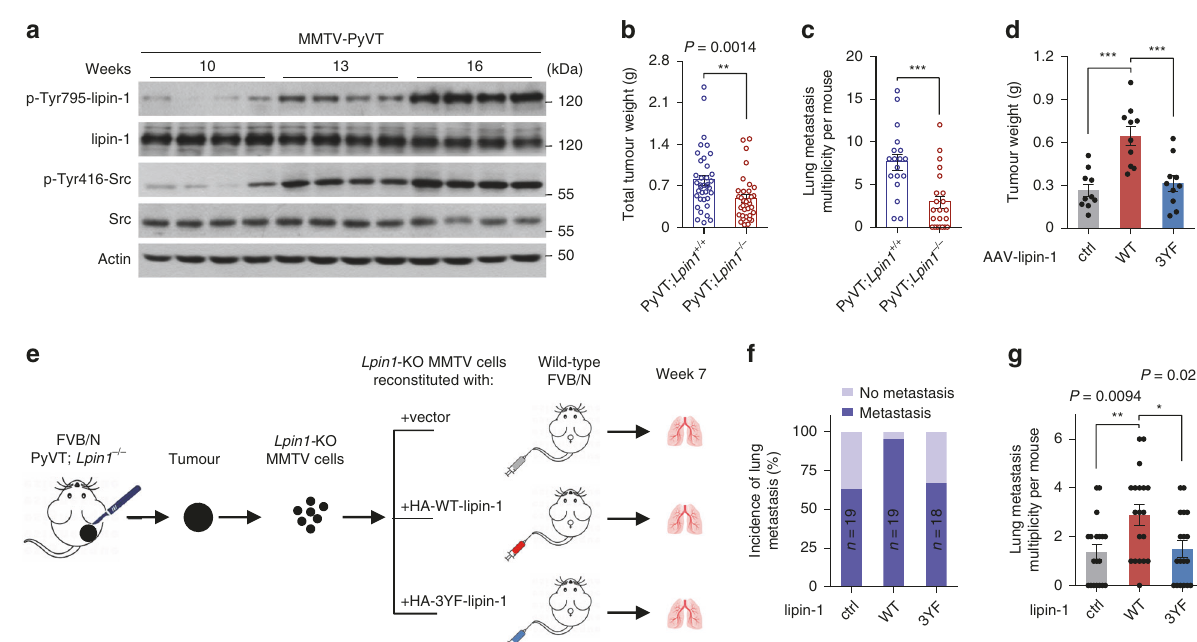
Fig. 4 Src-mediated lipin-1 phosphorylation is crucial for breast cancer progression in mice. a Immunoblots of breast tumour extract from MMTV-PyVT mice at 10, 13 and 16 weeks. Each lane represents proteins from one mouse. b Tumour weights of PyVT; Lpin1 + / + ( n = 37) and PyVT; Lpin1 − / − ( n = 34) mice. Experimental mice were killed at 14 weeks of age, and mammary tumours were then removed and weighed. n = 34 – 37 mice per group. c Multiplicity of lung metastasis. Metastasis multiplicity was determined by H&E staining of 14-week-old PyVT; Lpin1 + / + ( n = 18) and PyVT; Lpin1 − / − ( n = 22) mice. d Tumour weights of PyVT; Lpin1 − / − mice infected with adeno-associated viruses (AAV) carrying vector (ctrl), WT-lipin-1 or 3YF-lipin-1. The 6-week-old female Lpin1 − / − mice were anaesthetised and injected with 1 × 10 11 genome copies of AAV per fat pad, at 6 weeks post-injection, tumour weights of these mice were measured. n = 10 mice per group. e Schematic diagram of intravenous injection to generate experimental lung metastasis. Lpin1- KO MMTV cell line was isolated from a spontaneous mammary tumour in PyVT; Lpin1 − / − mice. 1 × 10 5 Lpin1- KO MMTV cells expressing GFP (ctrl), WT-lipin-1 or 3YF- lipin-1 were injected intravenously into 6-week-old FVB/N female mice ( n = 19 mice for ctrl or WT-lipin-1 group, n = 18 mice for 3YF-lipin-1 group). f Incidence of lung metastasis. Bars are the percentages of mice with lung metastasis. g Lung metastasis multiplicity was calculated at endpoint. b – d , g Data are mean ± s.e.m.; two-tailed Mann – Whitney test in b , c ; one-way ANOVA (repeated measure), followed by Tukey in d ; ordinary one-way ANOVA, followed by Tukey in g . *** P < 0.001, N.S. not signi fi cant. Source data are provided as a Source Data fi (higher half vs. lower half) of the p-Tyr795-low patients (Fig. 5l and Supplementary Fig. 10g, h). These clinical associations demonstrate that the Src-mediated lipin-1 tyrosine phosphor- ylation is highly correlated with human breast cancer malignancy and poorer prognosis.